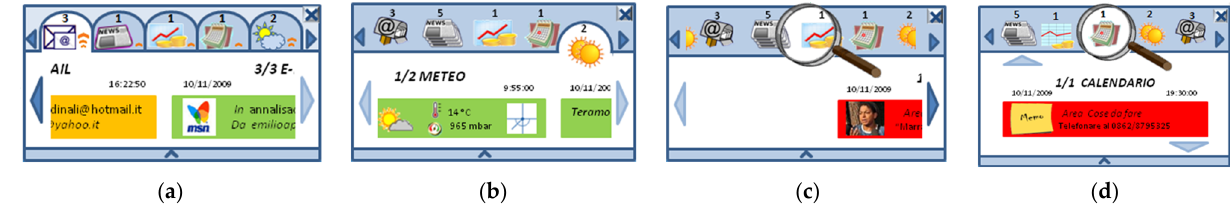
Figure 11. Four alternatives for the display: ( a ) A first type of tab-based category bar with horizontal scrolling of individual notifications; ( b ) a second type of tab-based category bar with horizontal scrolling of individual notifications; ( c ) lens-based category bar with horizontal scrolling of individual notifications; ( d ) lens-based category bar with vertical scrolling of individual notifications.